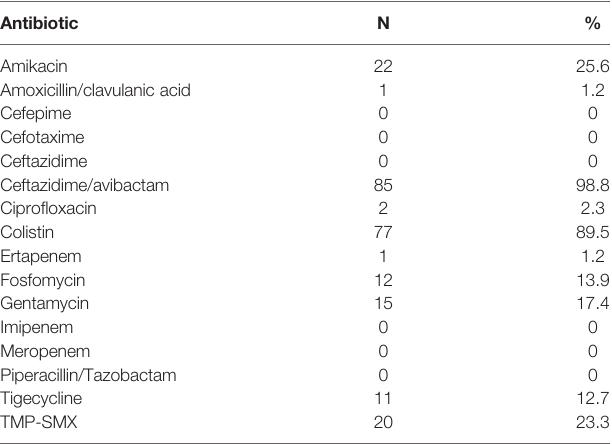
TABLE 2 | Antibiotic susceptibility pro fi le of carbapenem-resistant K. pneumoniae clinical isolates. Antibiotic